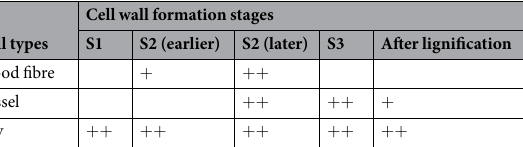
surface observed via cryo-TOF-SIMS/SEM analysis (Fig. 4a and b) and optical microscopy (Fig. 4c and d) was nearly at the same position as that obtained from the same sample block, and a similar tissue distribution was observed. The tissues were classified as cortex, phloem fibre, sclereid, secondary phloem, and ray cell.